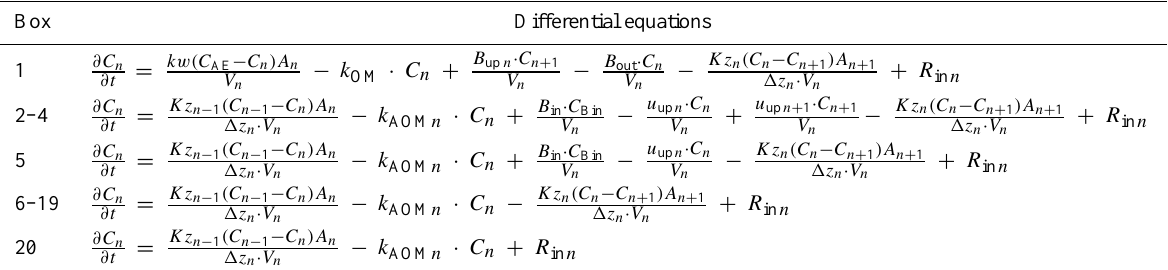
Table 2. Differential equations for each box (abbreviations are listed in Table 1). Box Differential